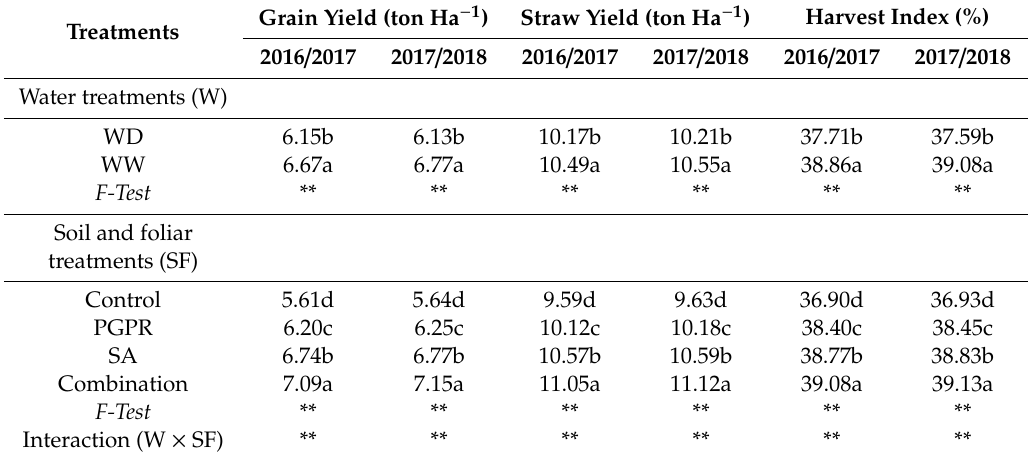
Table 7. Yield of wheat as affected by PGPR, SA, and their combination in 2016 / 2017 and 2017 / 2018 seasons.